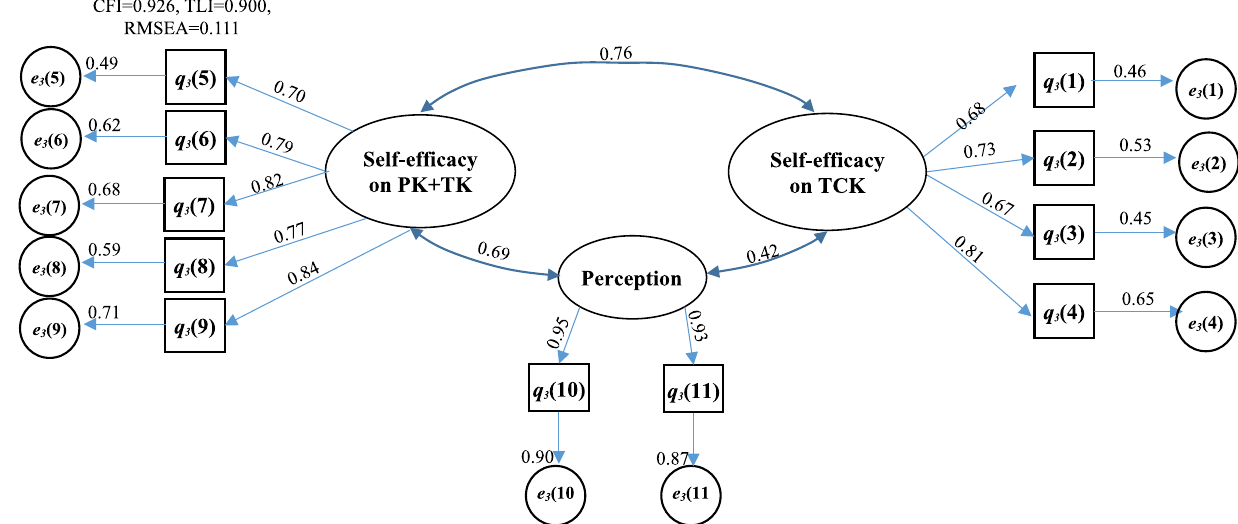
Fig. 4 Structural equation model describing the Self-efficacy of graduate student and themselves perceptions on the GTA’s program